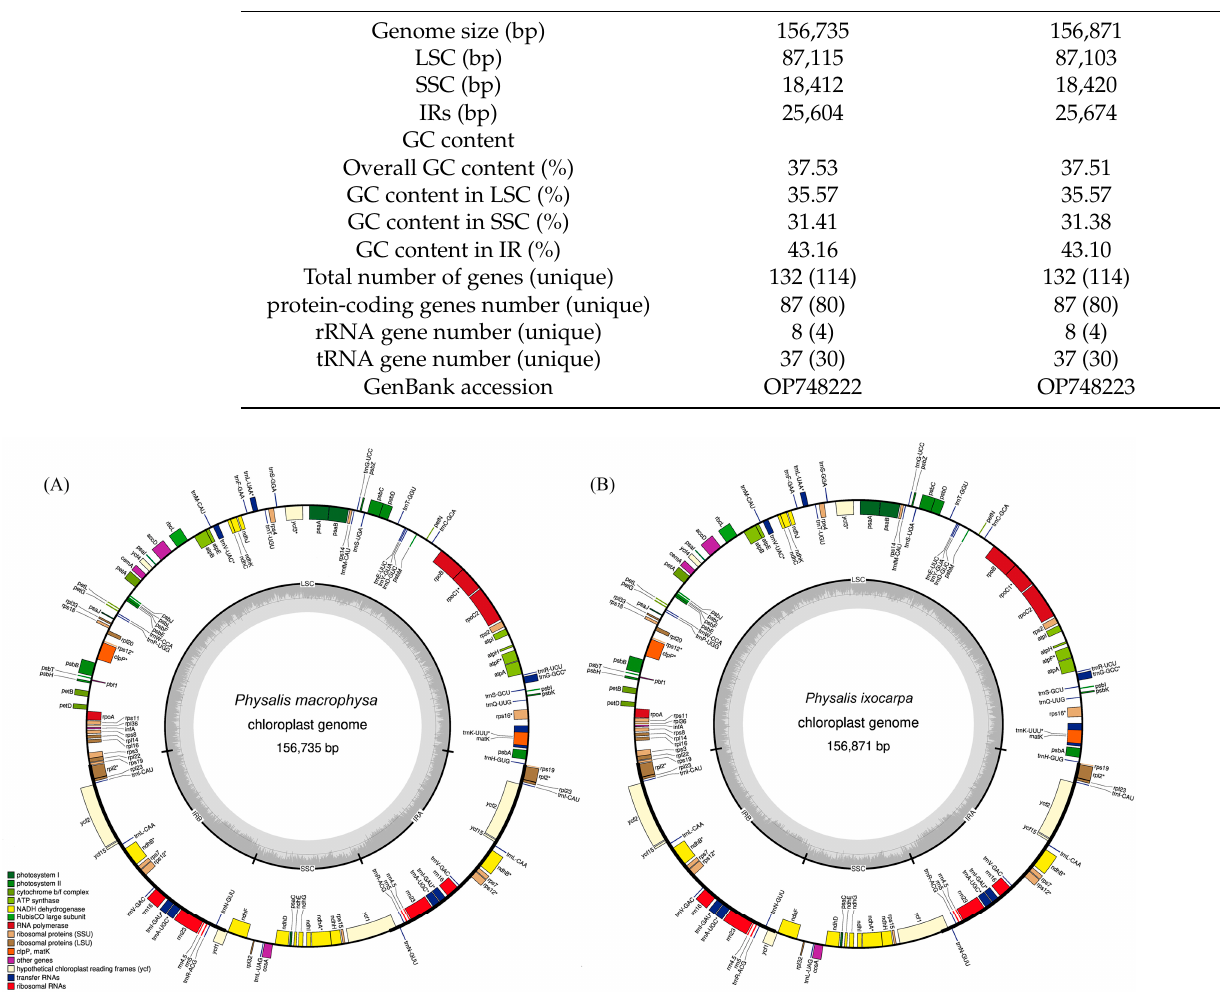
Figure 1. Gene map of the cp genomes of PMA ( A ) and PIX ( B ). Genes outside the circles are transcribed in a counter-clockwise direction, and genes inside the circles in a clockwise direction. Known functional genes are color coded. AT and GC contents are denoted by light and dark gray in the inner circle, respectively. LSC: large single copy region, SSC: small single copy region, IRa and IRb: inverted repeat